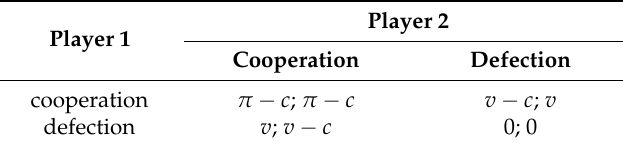
Table 1. Payoff matrix of the